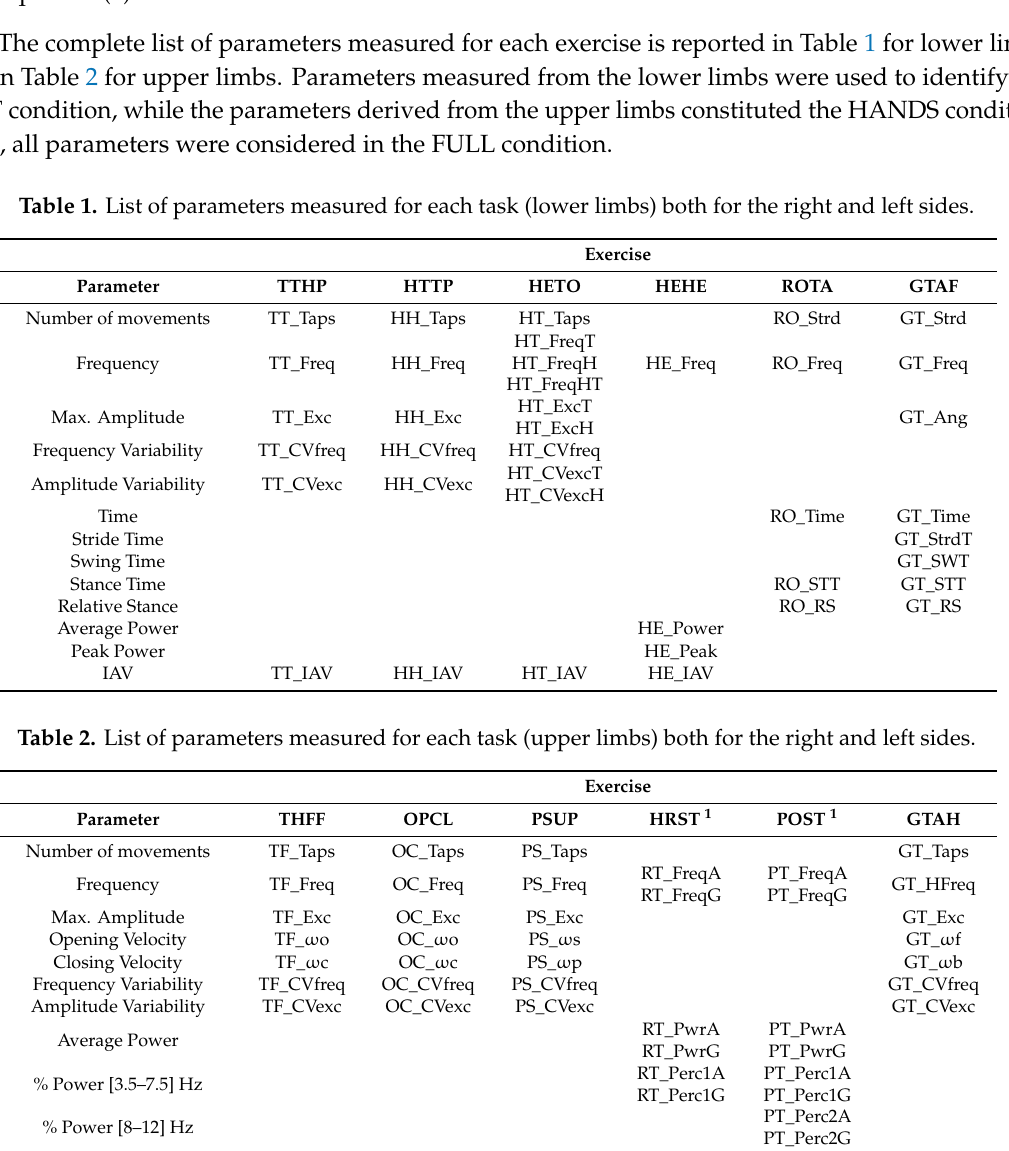
Table 1. List of parameters measured for each task (lower limbs) both for the right and left sides.